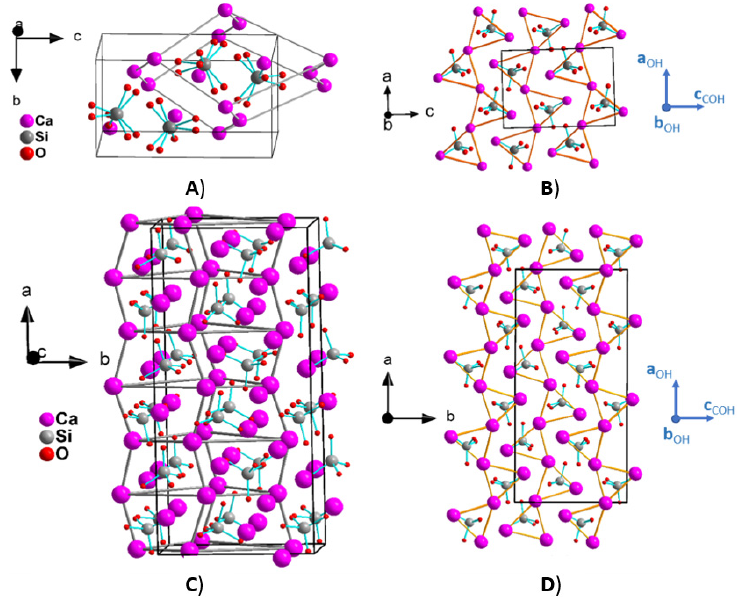
Figure 6. ( A ) The unit cell content and ( B ) the packing arrangement of trigonal prisms for α ’ H - Ca 2 SiO 4 polymorph is shown. ( C ) The unit cell content and ( D ) the packing arrangement of trigonal prisms for α ’ L -Ca 2 SiO4 polymorph structural model are shown. Si-O bonds are indicated with cyan lines. In ( B , D ), the structures are projected on the (010) planes, the trigonal prisms are demarcated with orange lines and the relative orientation of the ortho-hexagonal reference system is also